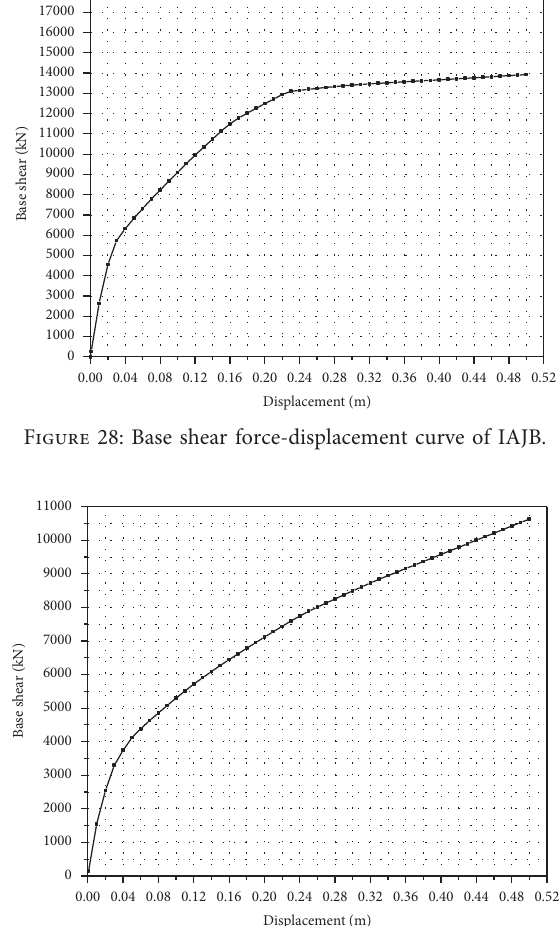
Figure 29: Base shear force-displacement curve of the conventional jointed bridge.